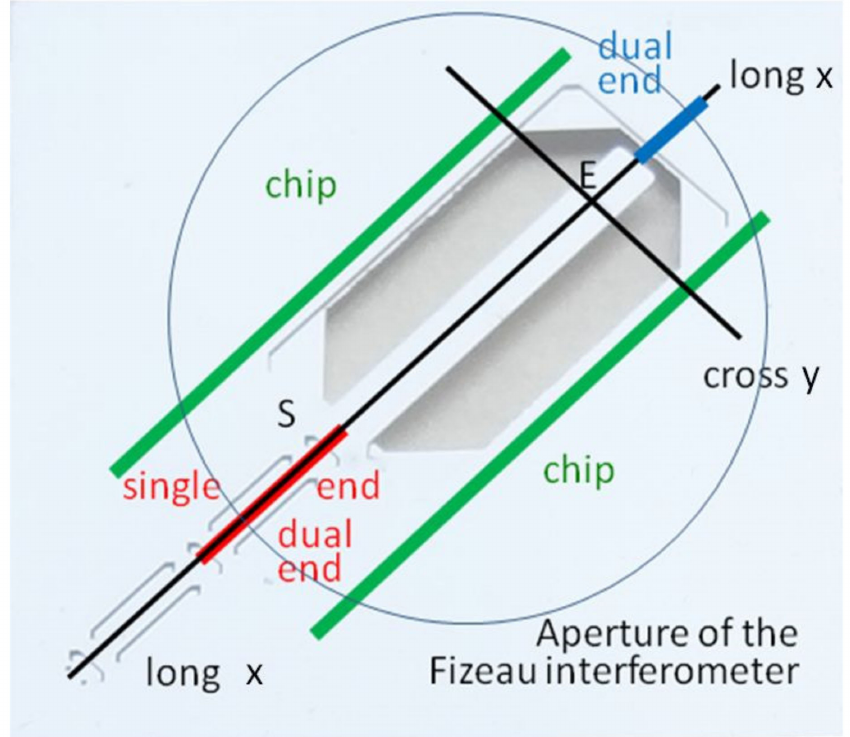
Figure 5. Schemes of the leveling approaches for evaluation of the zero-load bending of cantilevers and of the autofocus measurement of profiles for the determination of the zero-load bending (black lines). The direction “cross” yields z 0 E , while the longitudinal direction “long” yields the profile z 0 ( x ). The angle of inclination ϕ of these ROL can be determined by the least-square linear fitting (trendline) z = x tan ϕ + z 0 . Then, the rotated profile has the coordinates x (cid:48) , z (cid:48)